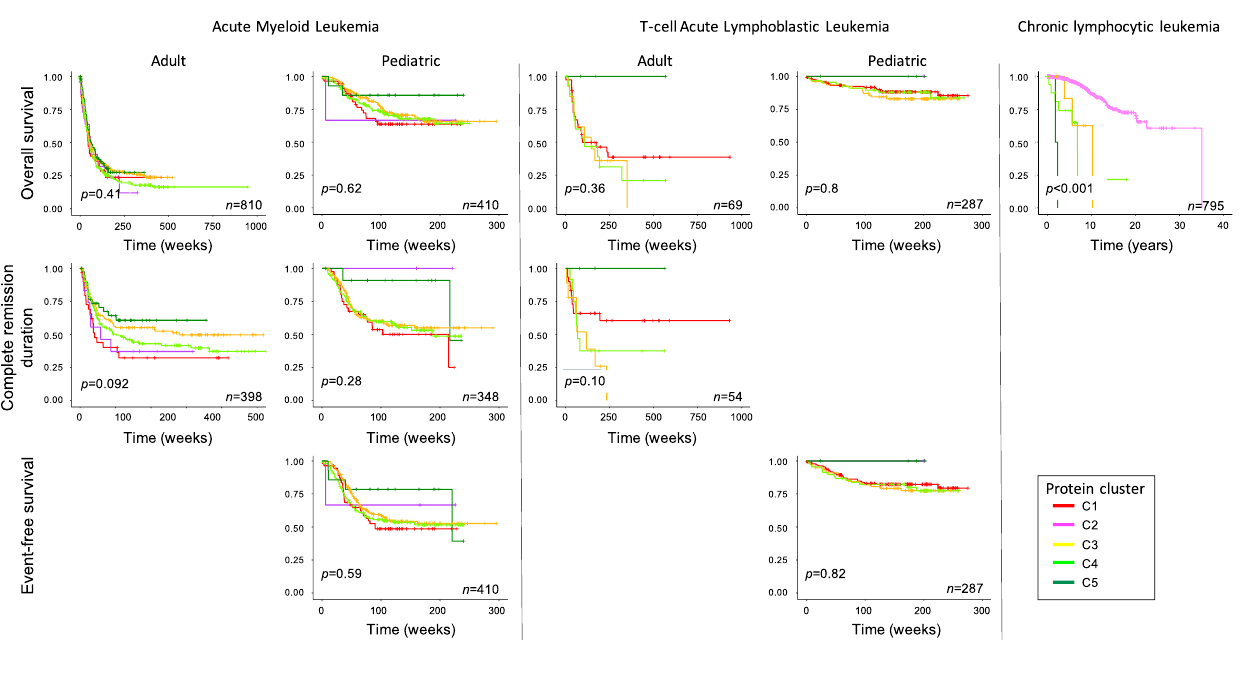
Figure 4. Association of DDR cluster membership with survival outcome. Overall survival (top row), complete remission duration (middle row) and event-free survival (bottom row) are shown for acute myeloid leukemia (left), T-cell acute lymphoblastic leukemia (middle), both stratified into adult and pediatric age groups, and chronic lymphocytic leukemia (right). The number of patients is shown for each figure. p -value represents the overall p -value of the graph, not comparisons between individual